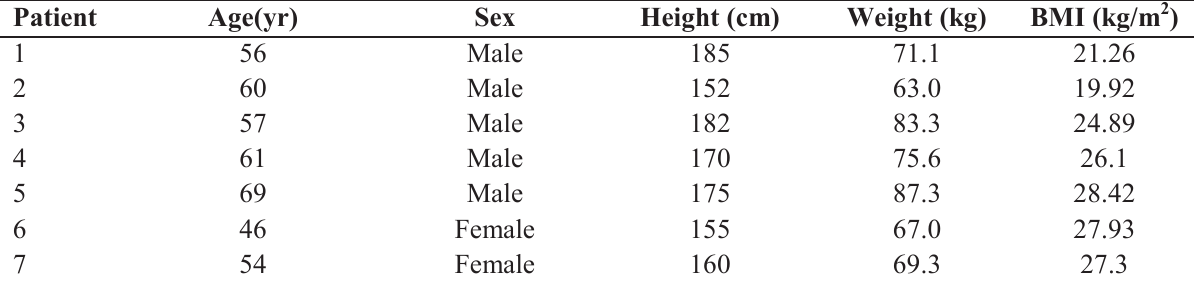
Table 1 - Patient Demographic data.